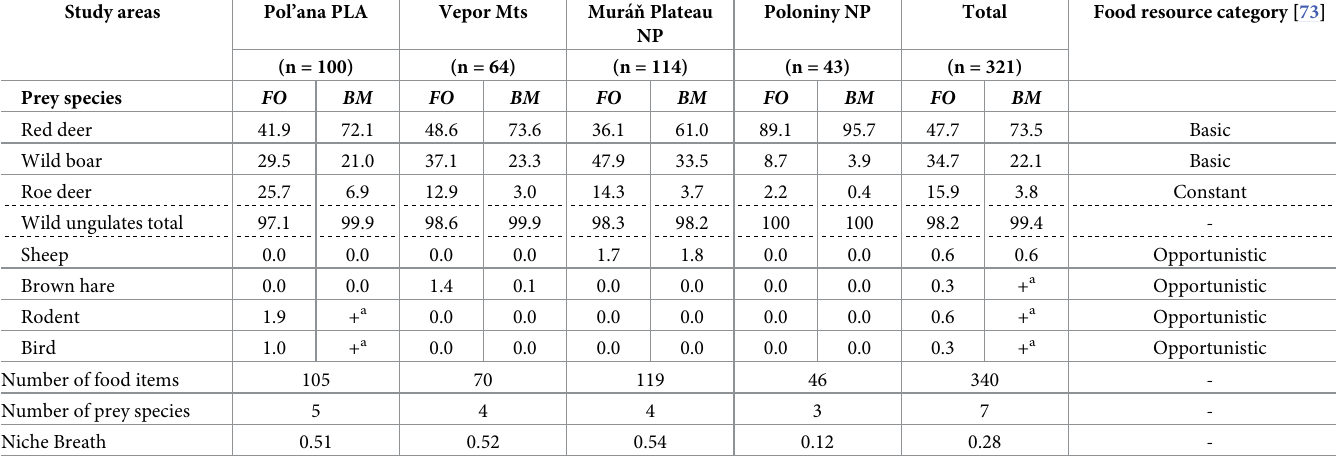
Table 1. Winter diet composition of wolves in four study areas within the Slovak Carpathians from 2015 to 2017 (n = 321). Measured as the percentage of occurrence ( FO ) and the percentage of the consumed biomass ( BM ). Is also shown the food resource category for each prey species in total as well as the n˚ of food items, n˚ of prey species and Niche Breath for each study